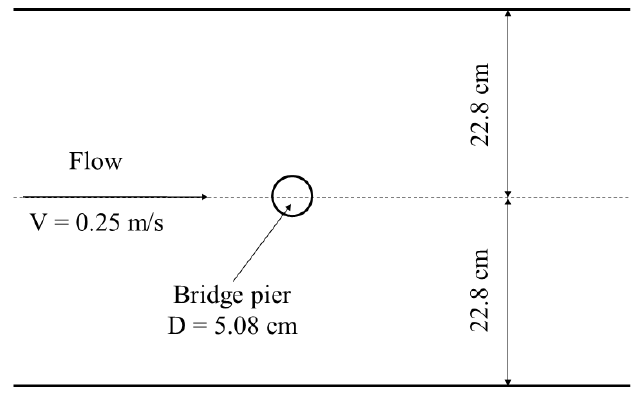
Figure 1. The layout of the flume (top view).